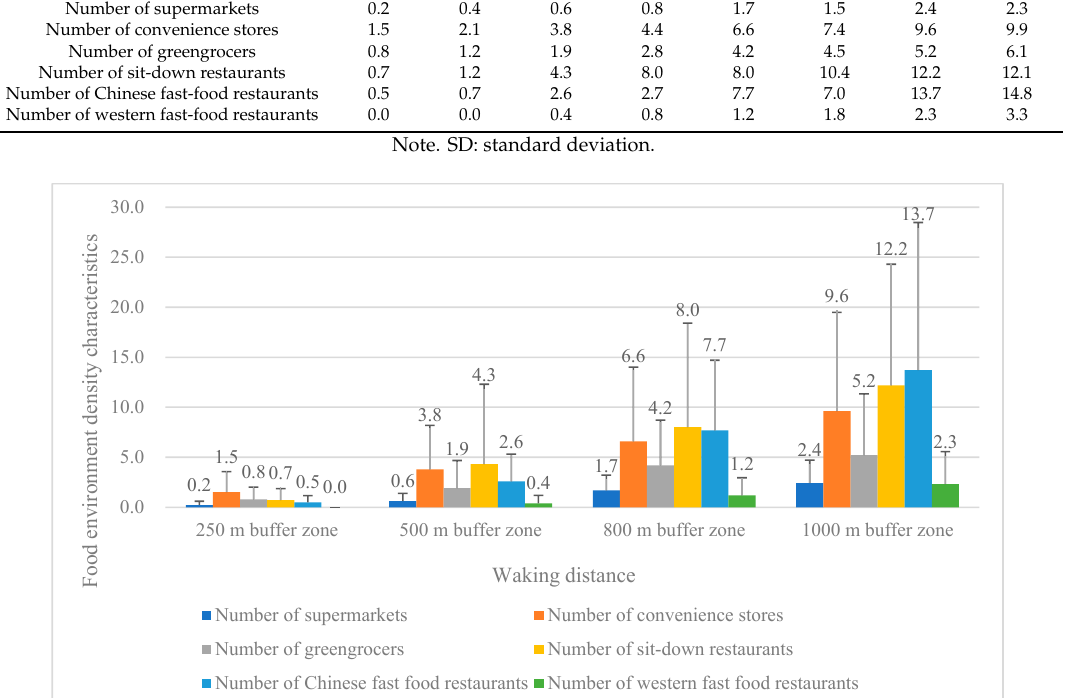
Table 3. Participants’ neighborhood food environment proximity characteristics. Figure 1. Participants’ neighborhood food environment density characteristics.